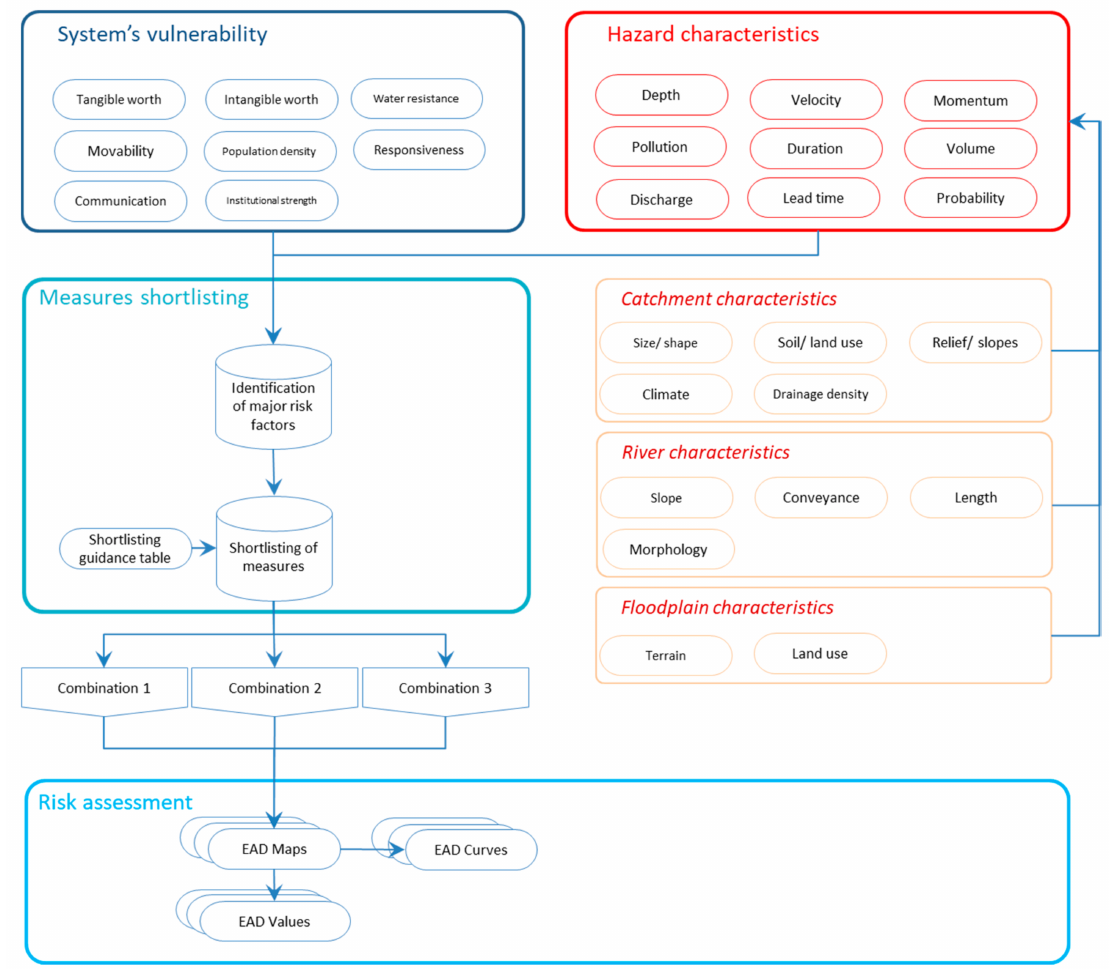
Figure 2. A proposed basic framework for risk-based flood